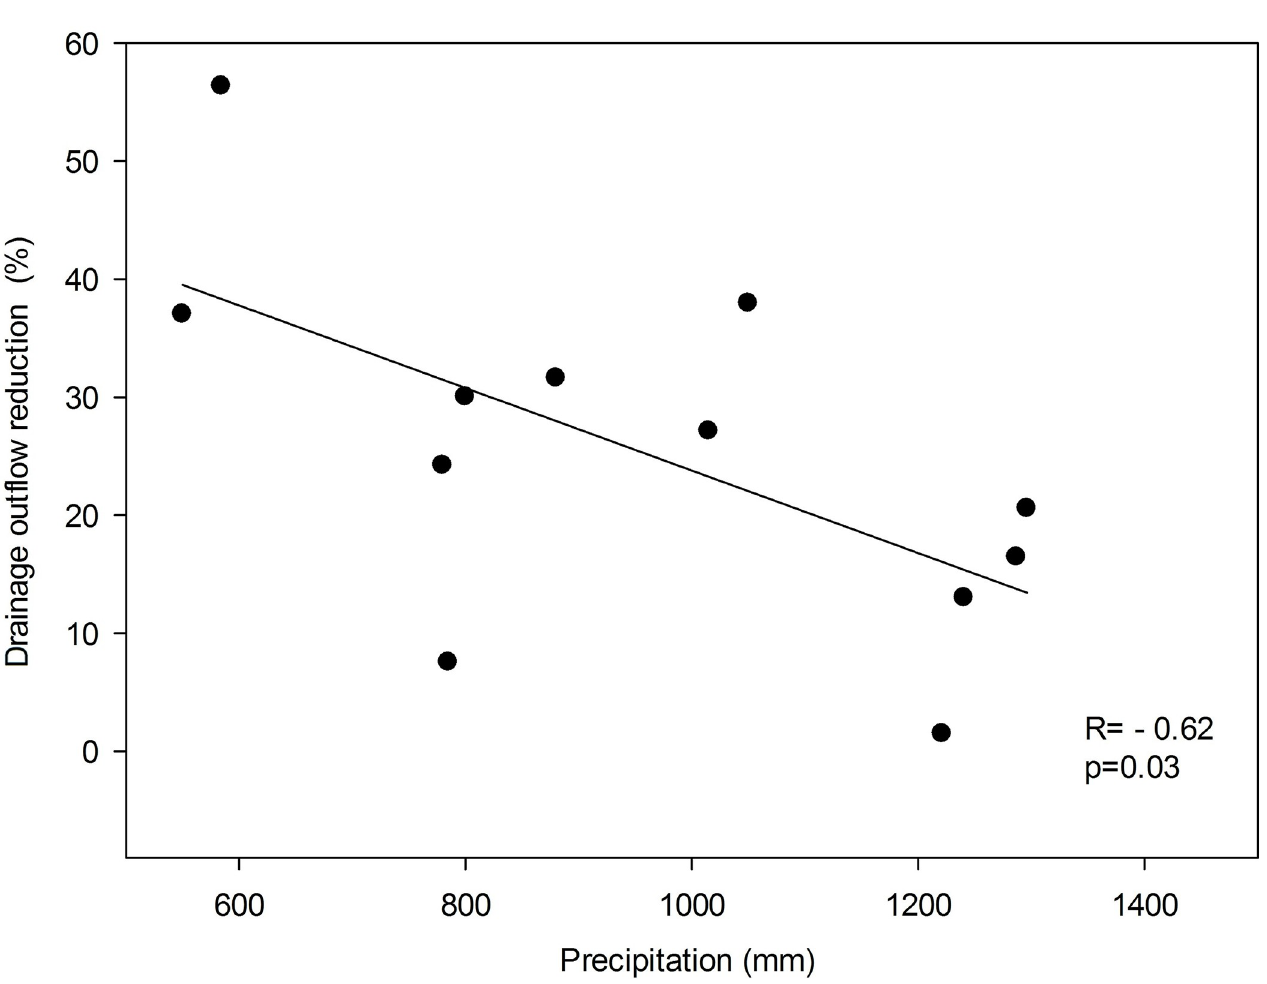
Fig 9. Reduction of drainage water with controlled drainage versus